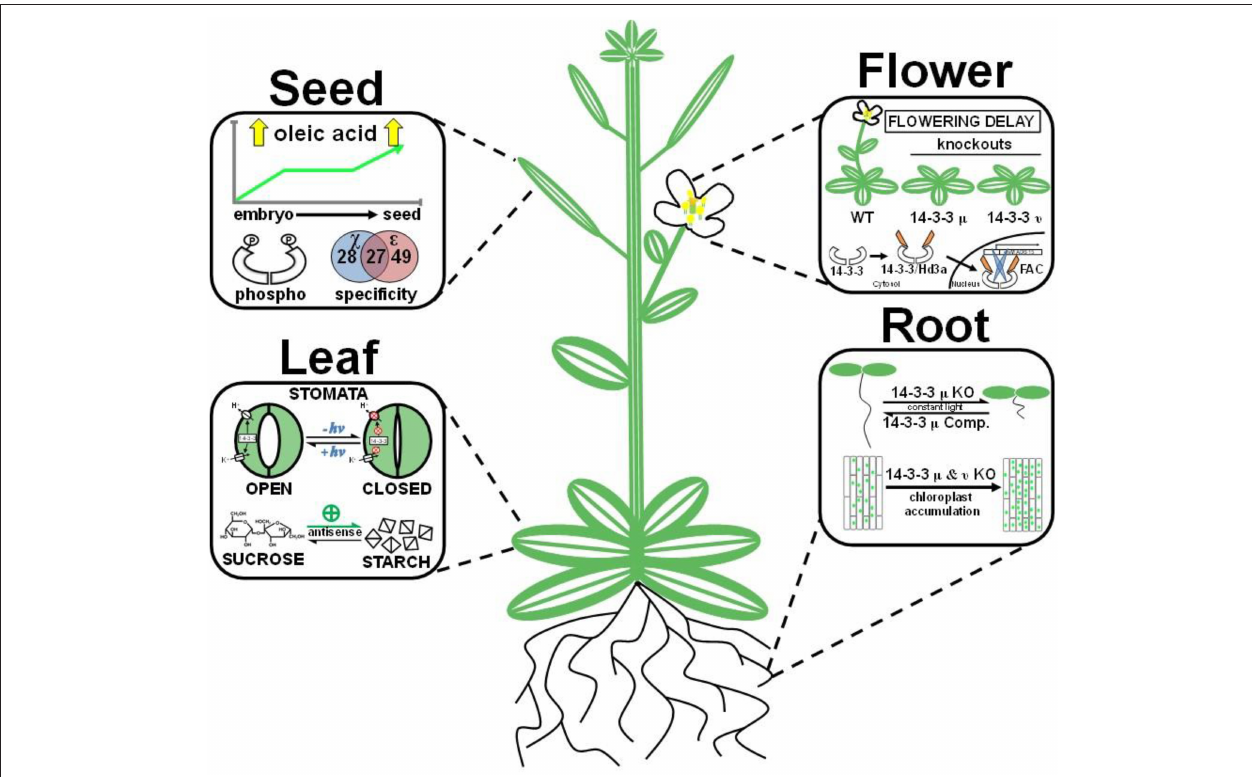
FIGURE 4 | Organ-specific mechanisms of plant 14-3-3 proteins. The figure displays specific 14-3-3 functions across the seed, flower, leaf, and root. Seed: 14-3-3 proteins are phosphorylated, display isoform-specific interactions, and have elevated expression levels in an isogenic sunflower line bred for high oleic acid content. Flower: 14-3-3 proteins act as a positive regulator of floral development. 14-3-3 µ and ν knockouts result in a flowering delay. Additionally, rice 14-3-3 proteins create a heterohexamer florigen activation complex (FAC) with bZIP transcription factor OsFD1 and FLOWERING LOCUST (FT) homolog Hd3a, which induces expression of a gene (OsMADS15) involved in floral development. Leaf: 14-3-3 acts as a positive regulator of blue light ( + h ν ) induced stomata opening by activating P-type H + -ATPases and voltage-gated K + channels. 14-3-3 antisense ( ε and µ ) lines increase starch accumulation in leaves. Root: 14-3-3 µ knockout lines (KO) severely stunt root growth, and complementation lines (Comp.) rescue the retarded root phenotype. 14-3-3 µ and ν knockout lines increase chloroplast accumulation in